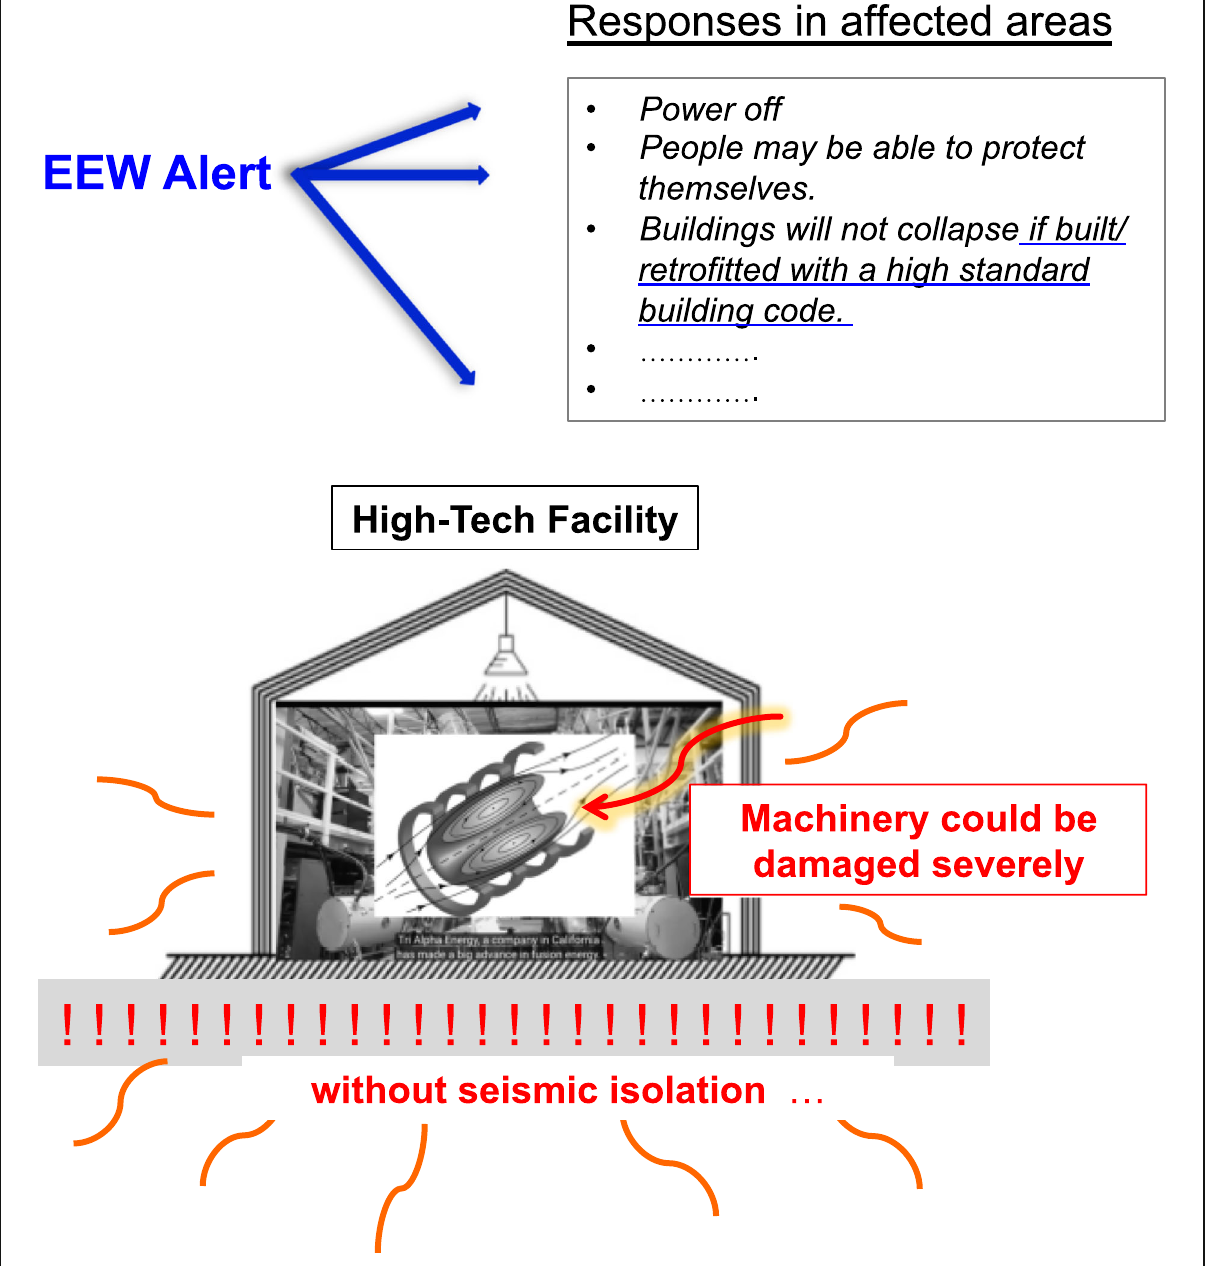
Fig. 2 Schematic illustration of responses to an EEW alert including a hypothetical high-tech facility. Upon receipt of an alert, the power may be shut down. People may be able to protect themselves and buildings may not collapse if they were built or retrofitted with a high-standard building code. However, at a high-tech facility, without a seismic isolation system beneath it, a strong shaking could directly hit vulnerable machinery and cause serious damage to it. For example, machinery in operation under high-voltage and high currents may not stop operating instantaneously after the power is turned